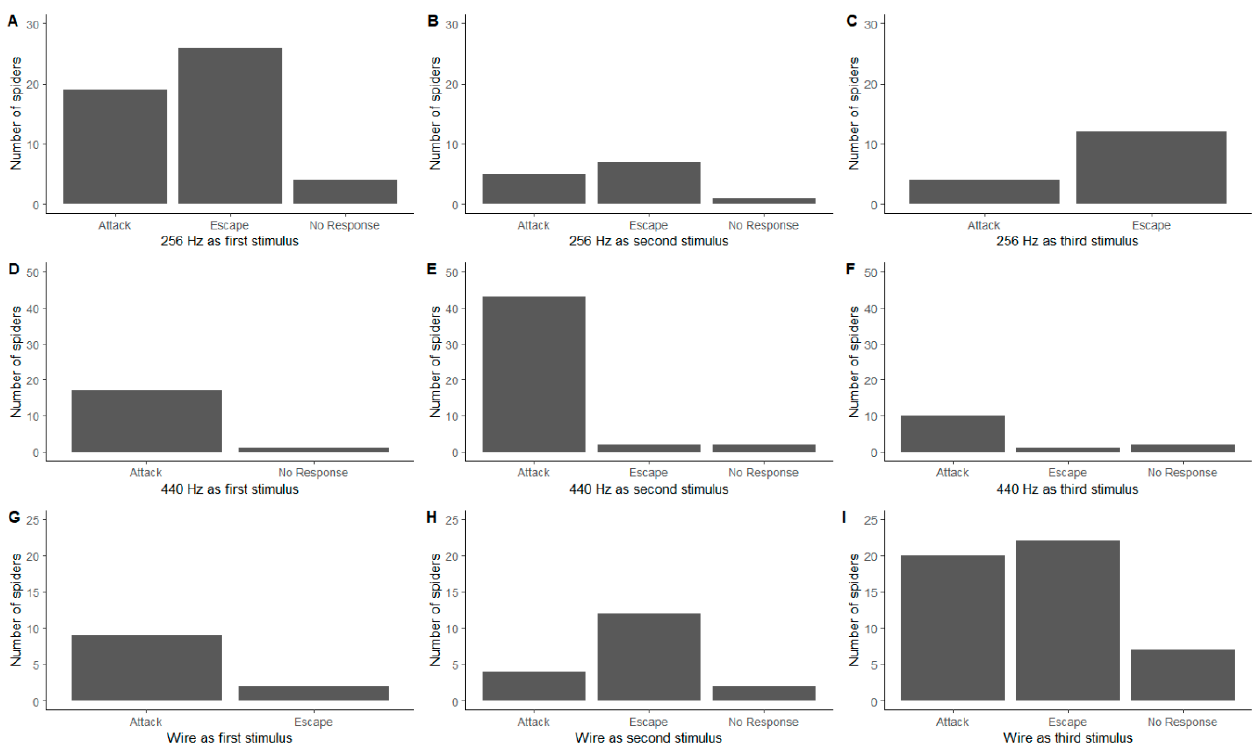
Figure 2. The influence of the order of the stimuli on the behavioural responses of Metellina segmentata . ( A – C ) 256 Hz tuning fork; ( D – F ) 440 Hz tuning fork; ( G – I ) length of wire.